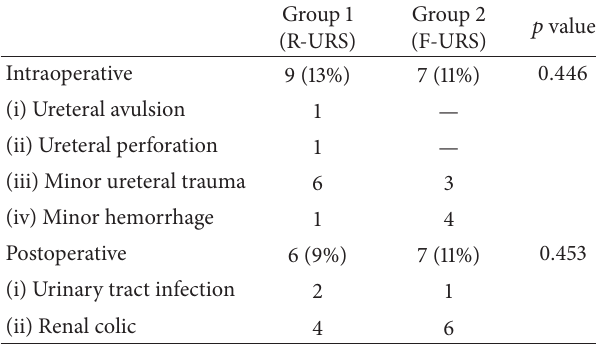
Table 3: Intraoperative and postoperative